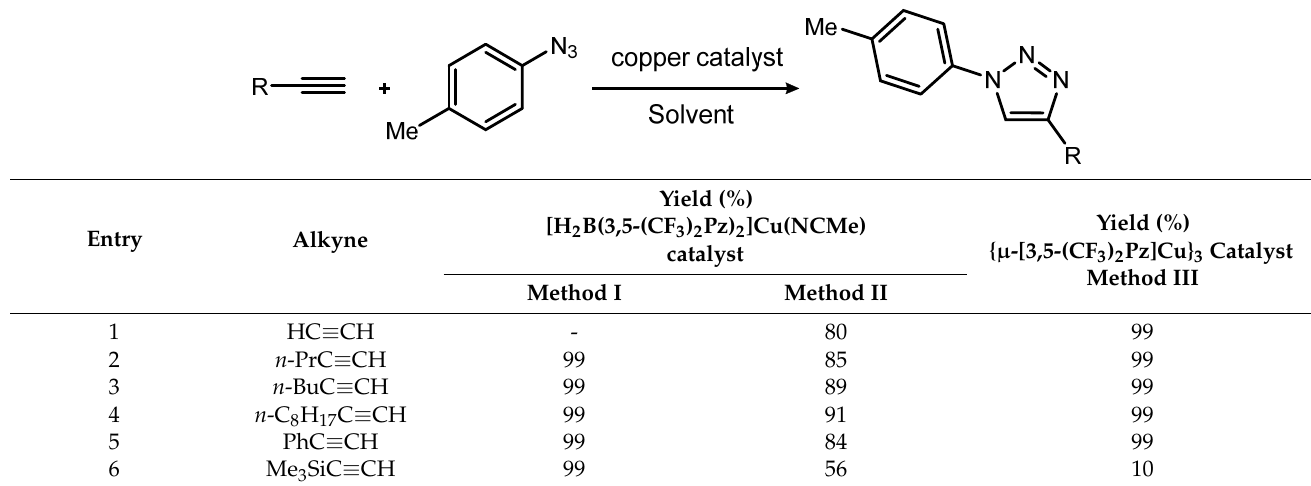
Table 3. Azide-alkyne cycloaddition mediated by the mononuclear bis(pyrazolyl)borate [H 2 B(3,5-(CF 3 ) 2 Pz) 2 ]Cu(NCMe) ( 1 ) and the trinuclear copper(I) pyrazolate { µ -[3,5-(CF 3 ) 2 Pz]Cu} 3 . Different Methods are described in the experimental section.